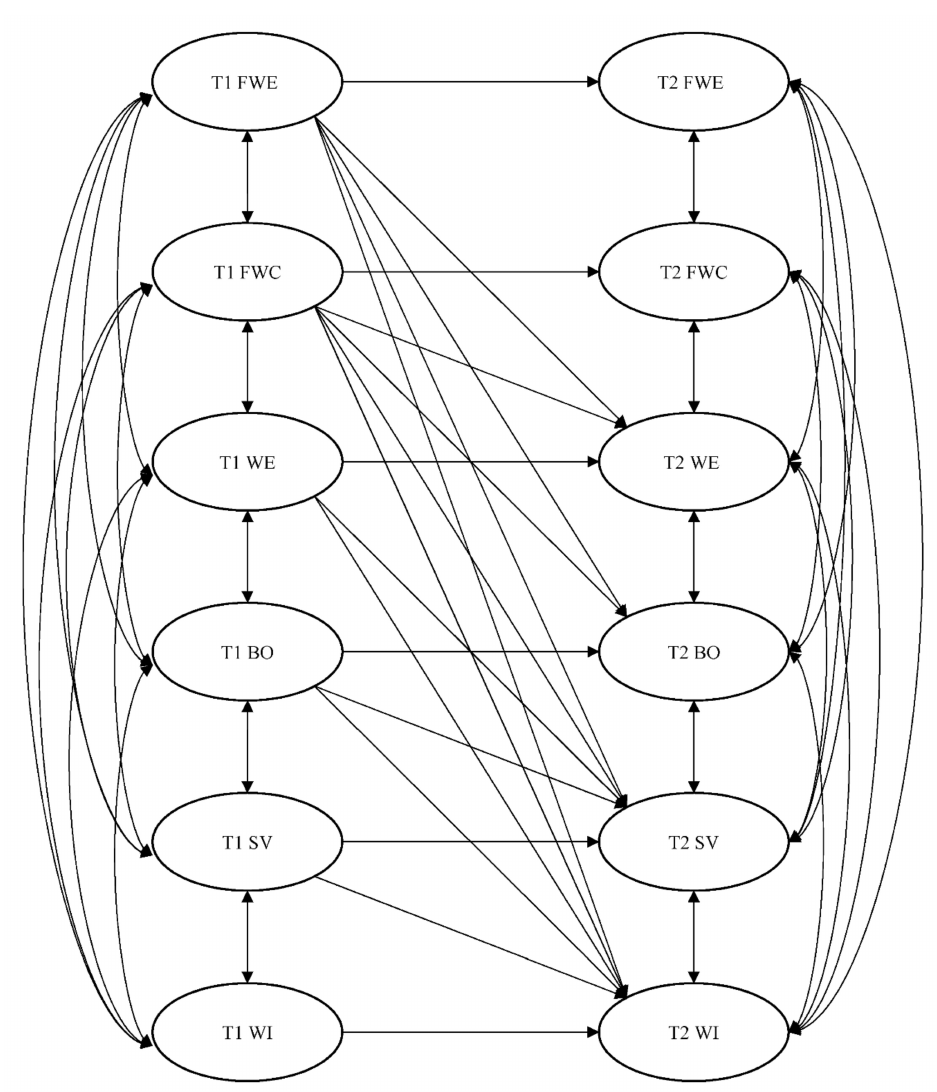
Figure 2. The hypothesized model. FWE = family-to-work enrichment; FWC = family-to-work conflict; WE = work engagement; BO = burnout; SV = safety violations; WI = workplace